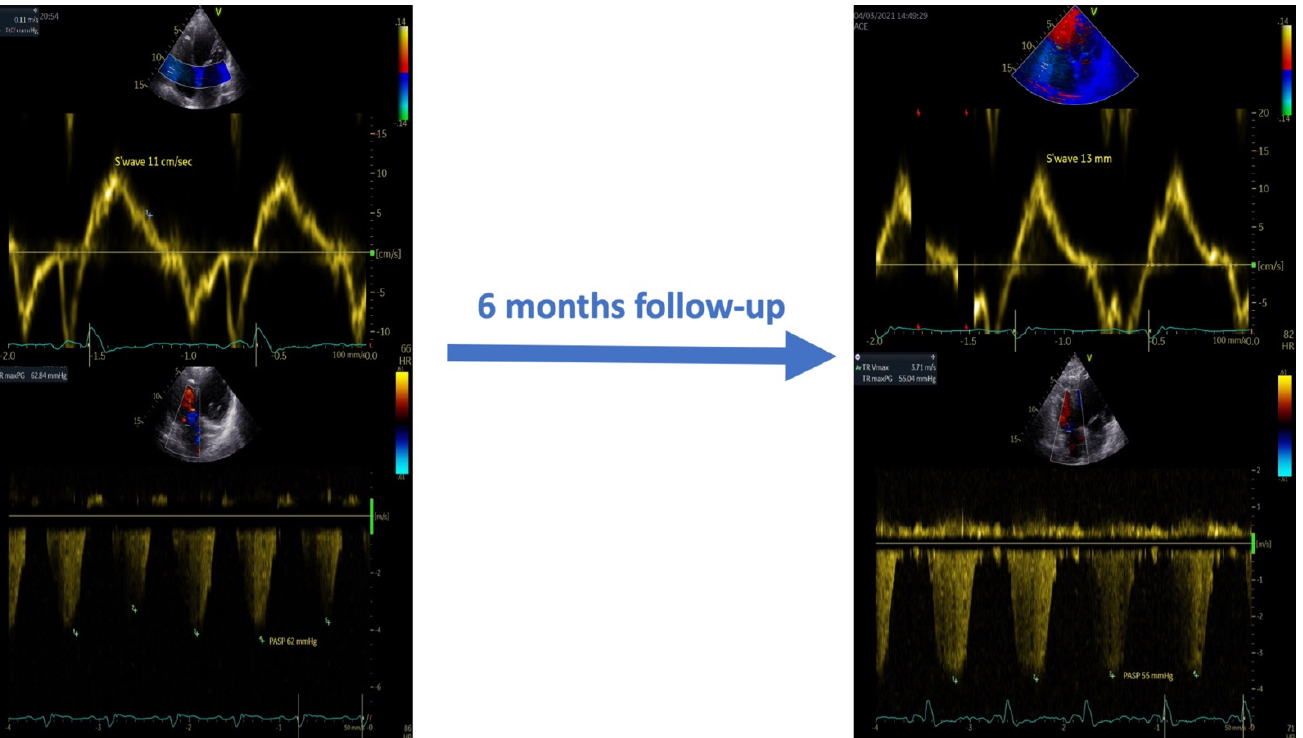
Figure 3. Effects of CCM therapy on the systolic function and pulmonary artery systolic pressure at the six-month follow-up. Table 2. Effects of CCM on the right ventricular dimensions, systolic function, and hemodynamic parameters at the six-month follow-up.